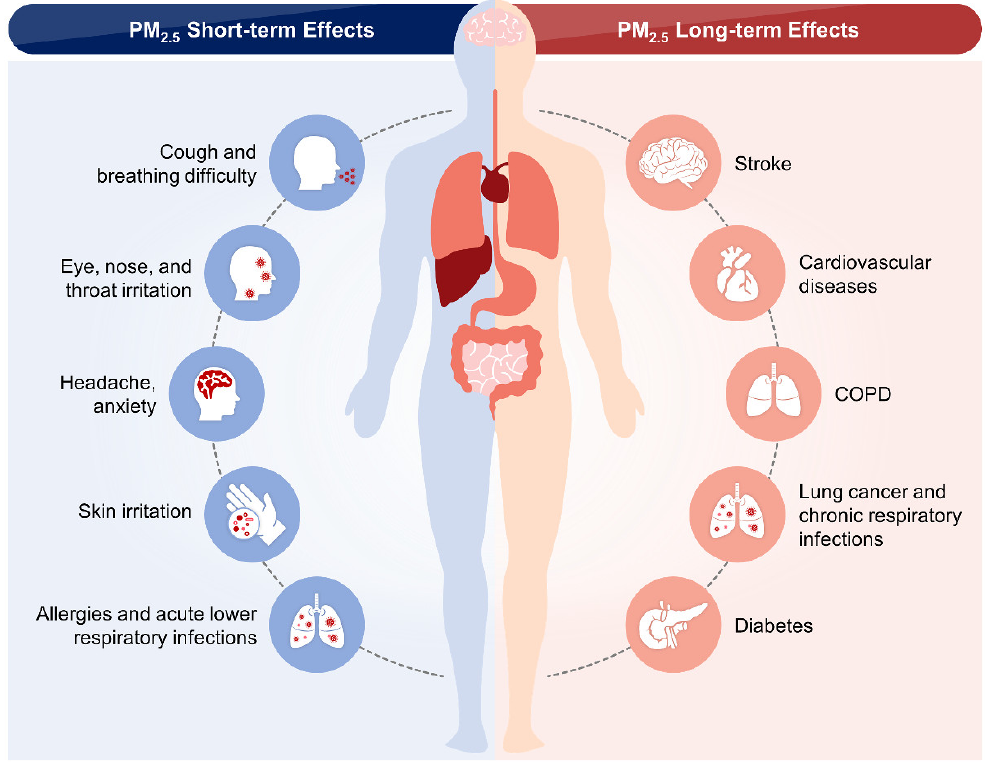
Figure 2. Short- and long-term effects of PM 2.5 on human health. The inhalation of particulate matter (PM) can irritate the lining of the nasal cavity, thereby inducing runny nose and cough. Inhaled PM can also travel deep down the airways and enter the lungs, thus triggering inflammation and causing shortness of breath, as well as worsening preexisting respiratory diseases such as asthma and chronic obstructive pulmonary disease (COPD). The inflammation can also spread to other parts of the body, leading to the risk of cardiovascular diseases. Lung cancer-related deaths are also related to the adverse effects of PM.